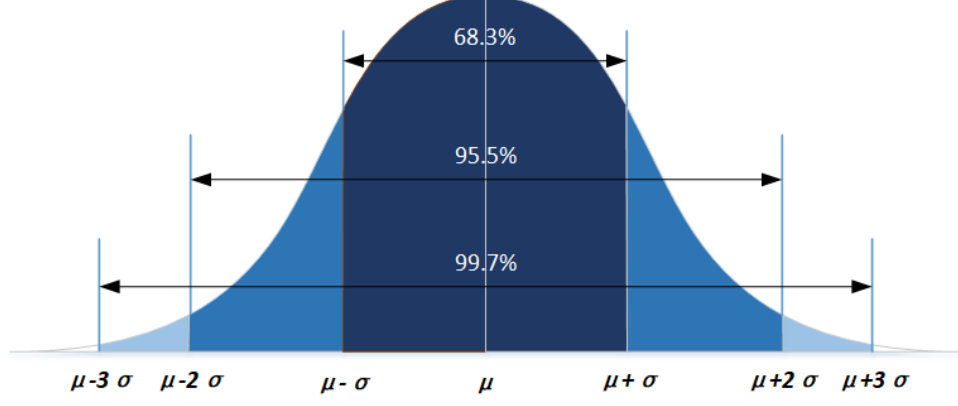
Figure 8. The probability density of one-dimensional Gaussian distribution.